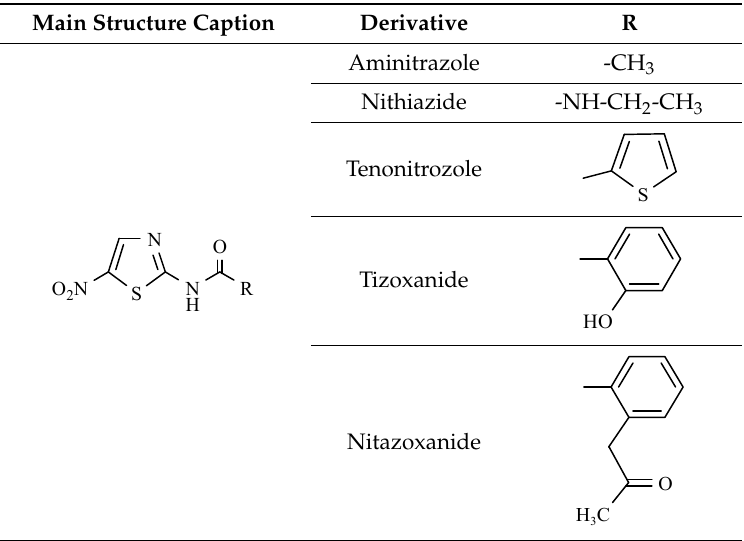
Table 5. Antiprotozoal 5-nitrothiazole derivatives.